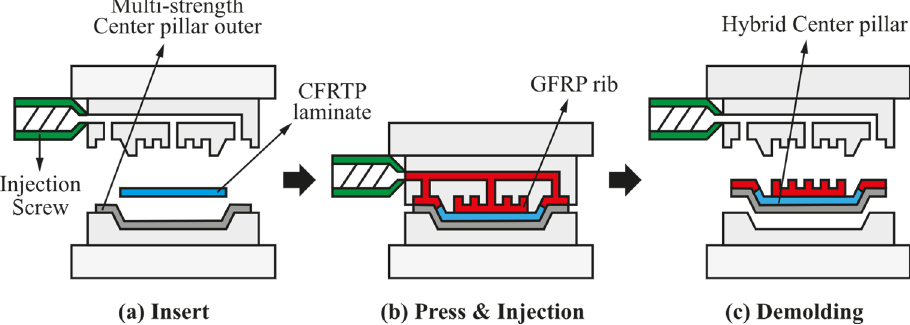
Figure 2. Schematic of hybrid molding process: ( a ) insert steel center pillar outer and CFRTP laminate; ( b ) compression molding process for CFRTP laminate and injection molding process for GFRP; ( c ) demolding process.